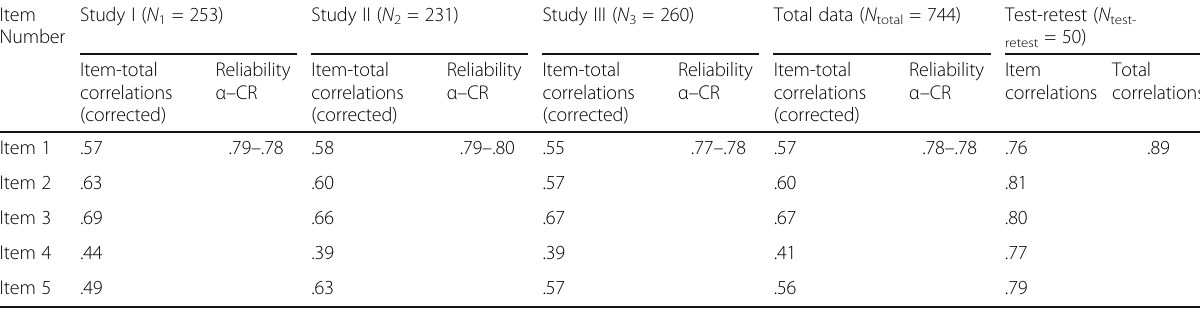
Table 5 Reliabilities of the Turkish-HiL Item Study I ( N 1 = Number